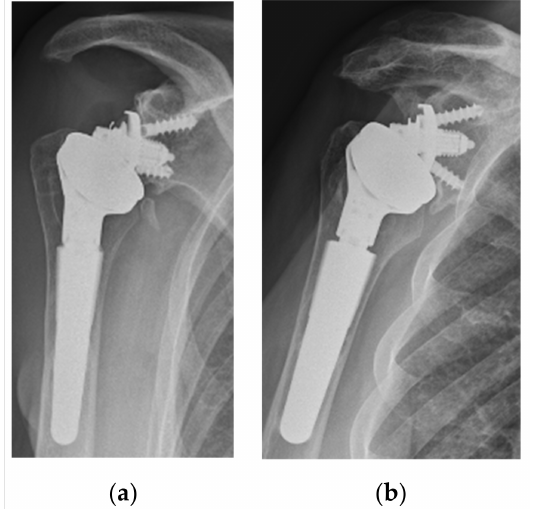
Figure 5. Two cases with a high glenoid position that developed a grade 1 ( a ) and grade 2 ( b ) of notching with the formation of a bone spur.